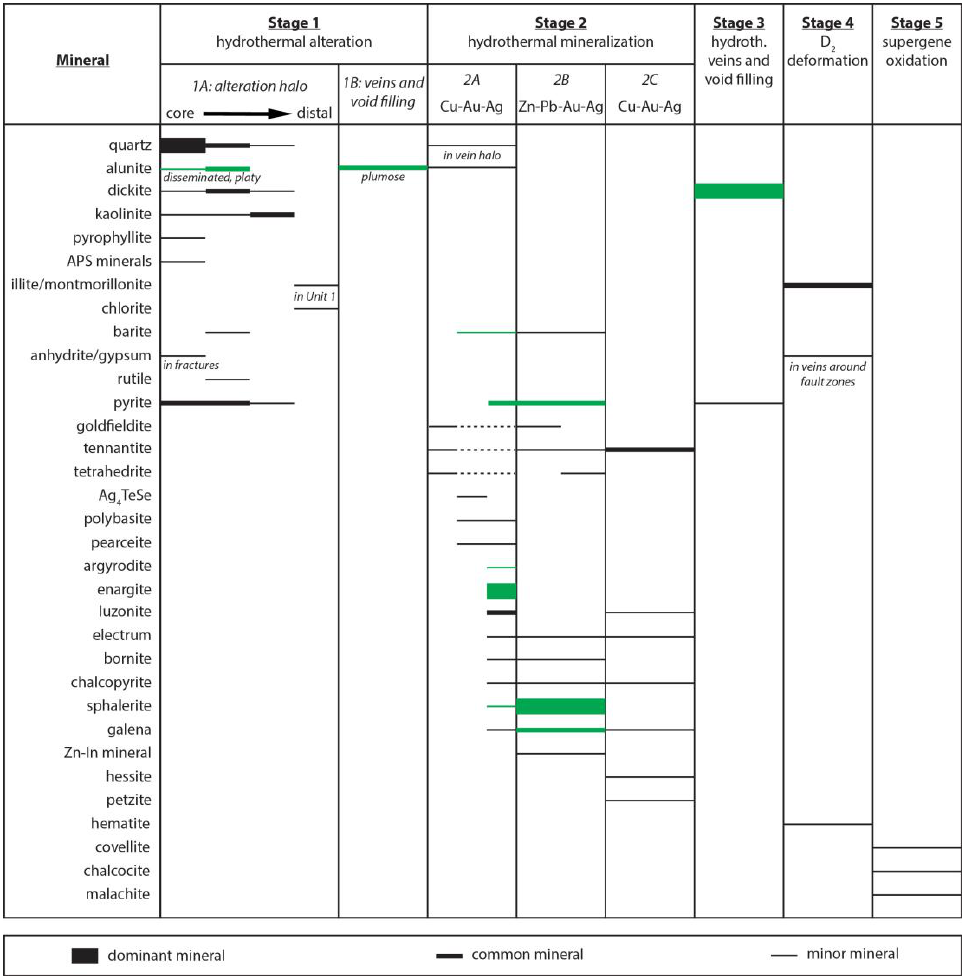
Figure 3. Paragenetic sequence of minerals at Mt Carlton. The minerals investigated in this study are highlighted in green. Modified from Sahlström et al. [30].